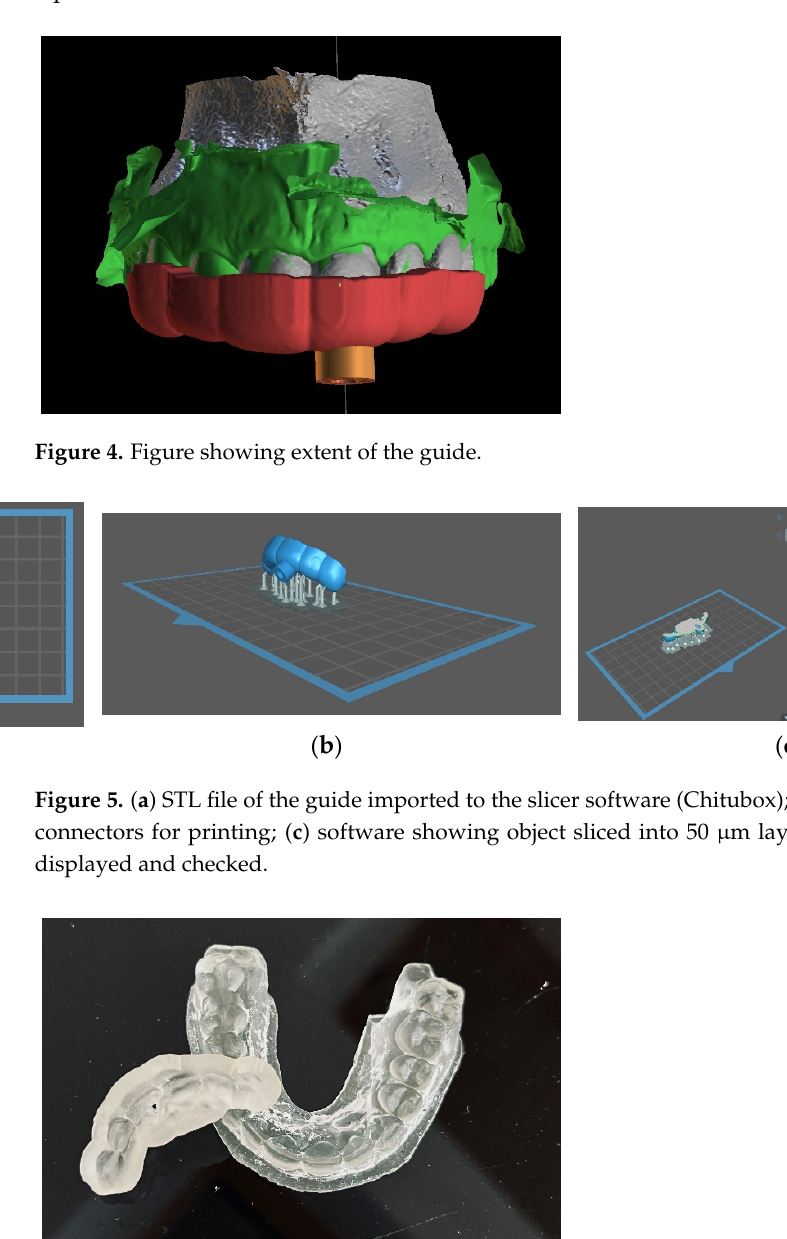
Figure 6. Endodontic guide and patient’s upper arch 3D-printed model.